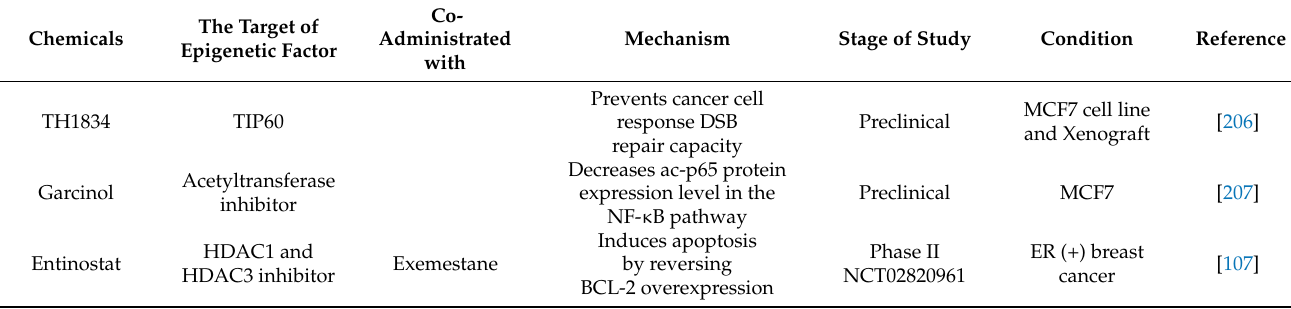
Table 1. Epi-drugs examined for luminal breast cancer